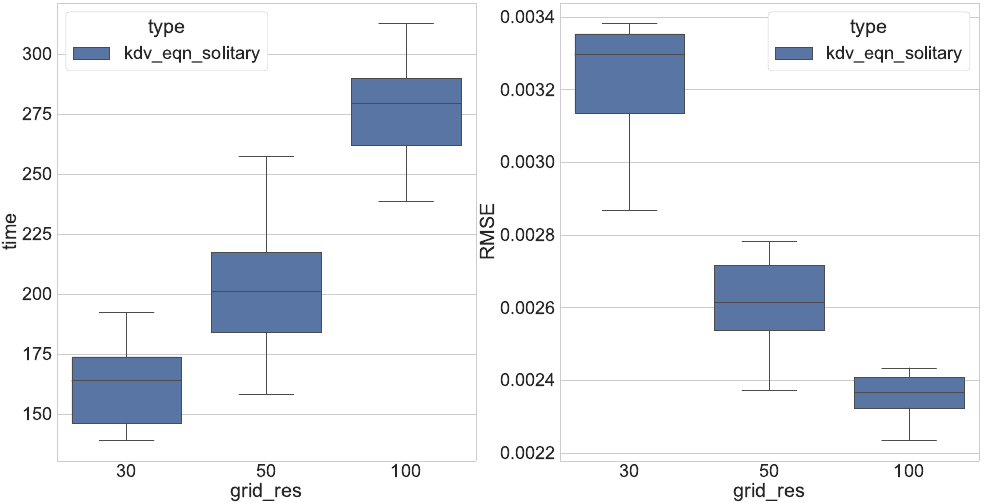
Figure 11. Results of the numerical solution to problem Equation (11) for a different number of discretization points. Computation time ( left ) and RMSE with respect to the analytical solution Equation (20) ( right ). All experiments were performed with cache=True